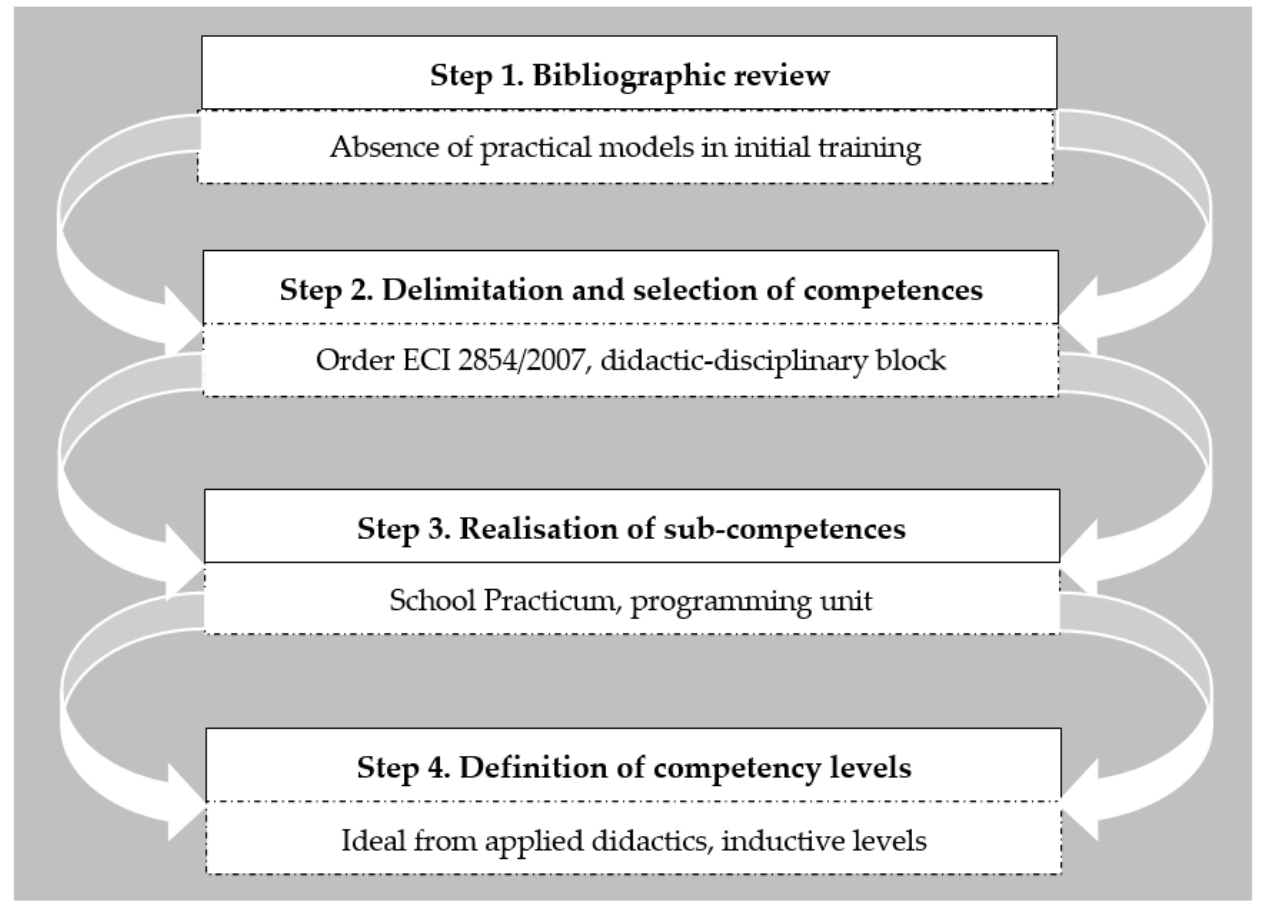
Figure 1. Method for the configuration of the model.